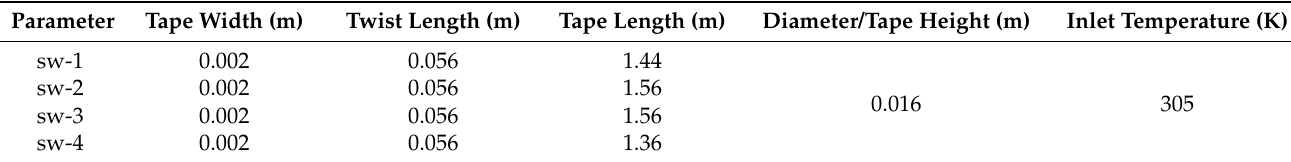
Table 2. Base structural parameters for parametric